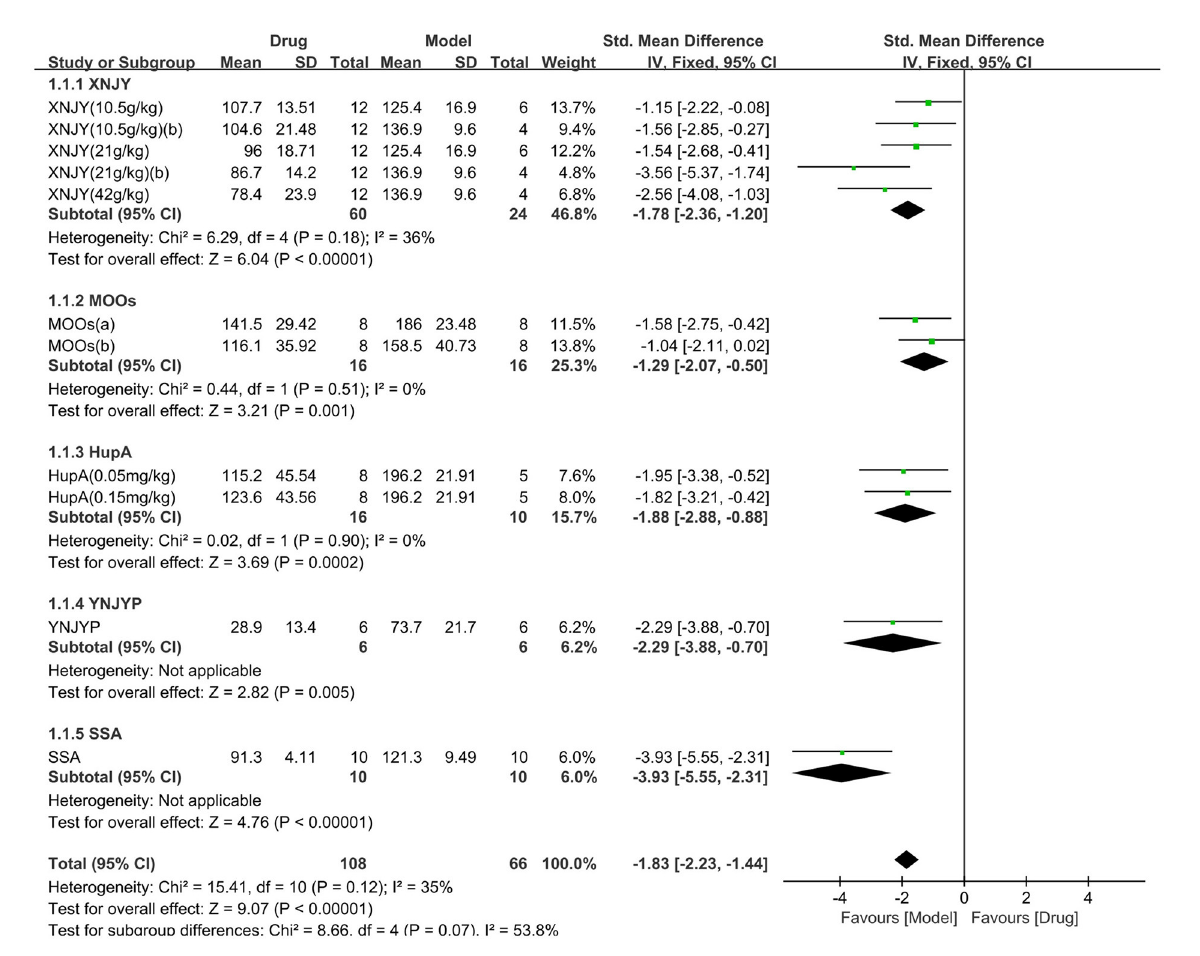
FIGURE4 Efficacy of CHM on forced swimming test. Forest plots of the effect size calculated using SMDs. The horizontal error bars represent the 95% confidence interval of individual studies.